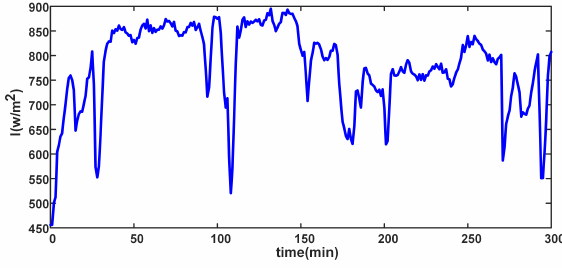
Fig. 2. Variation curve of solar radiation intensity.